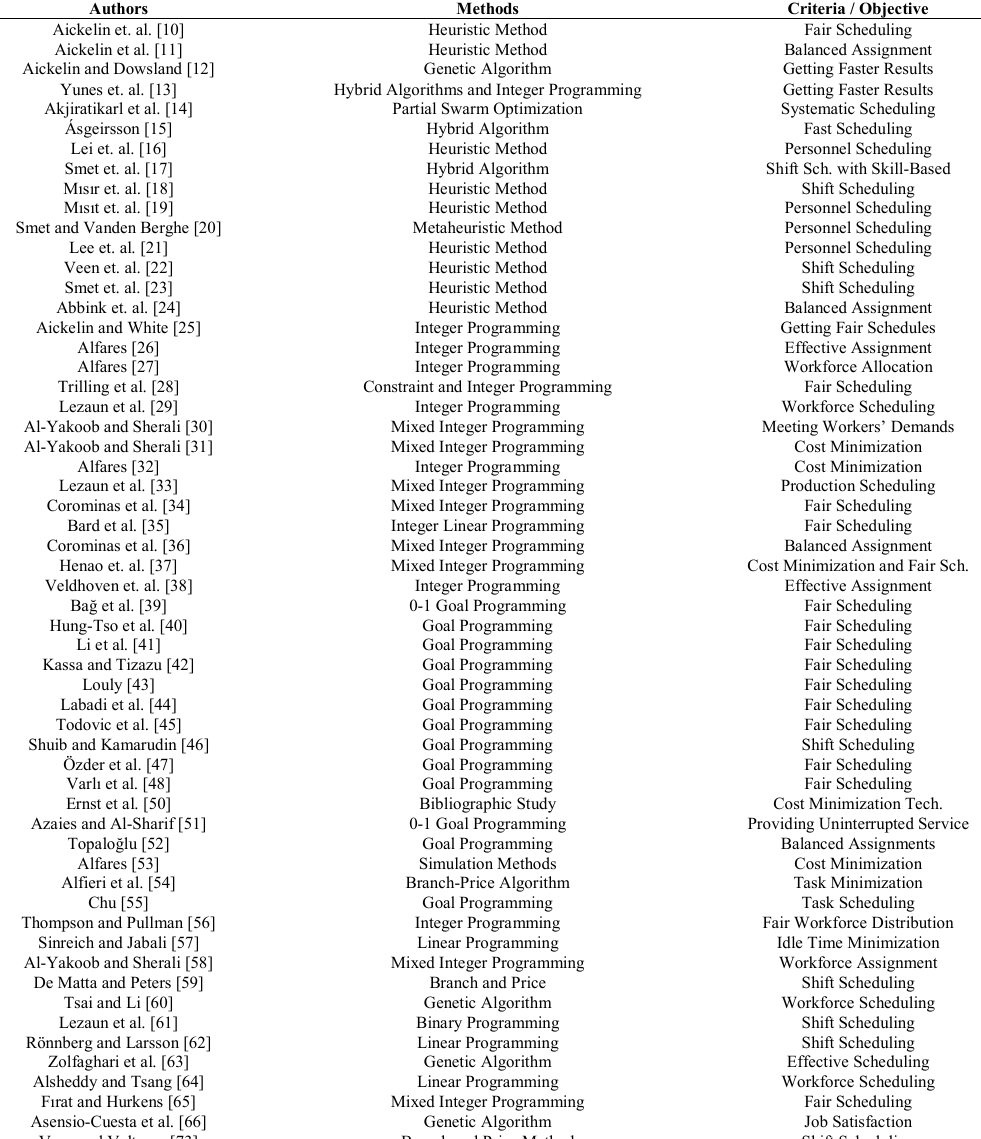
Figure 2. Literature Overview